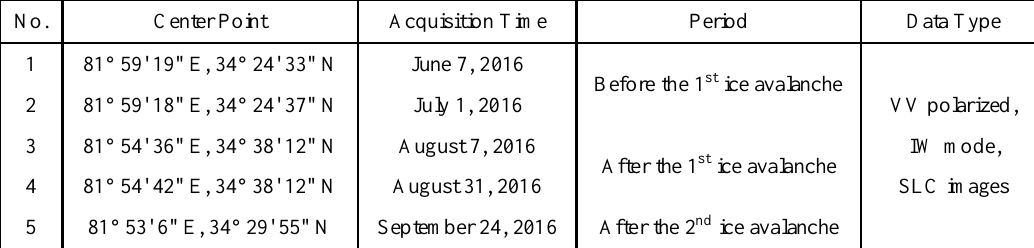
Table 1. Data distribution of Sentinel-1